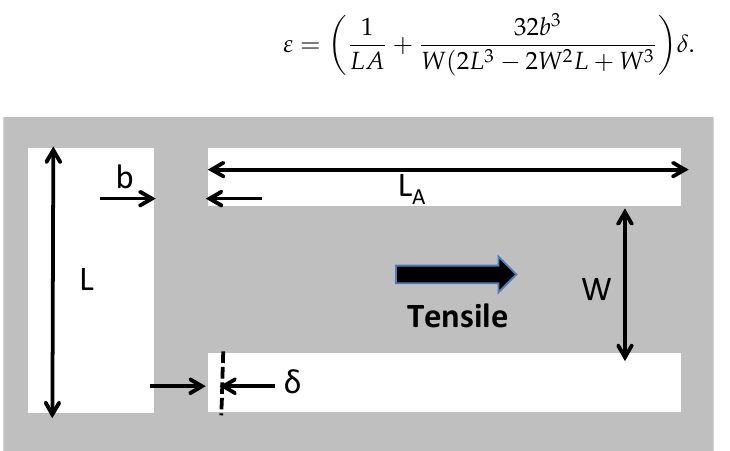
Figure 10. Illustration of the T-structure for measuring residual stress in thin-film layers. Using the calculated value of the strain and the Young’s modulus allows the residual stress to be